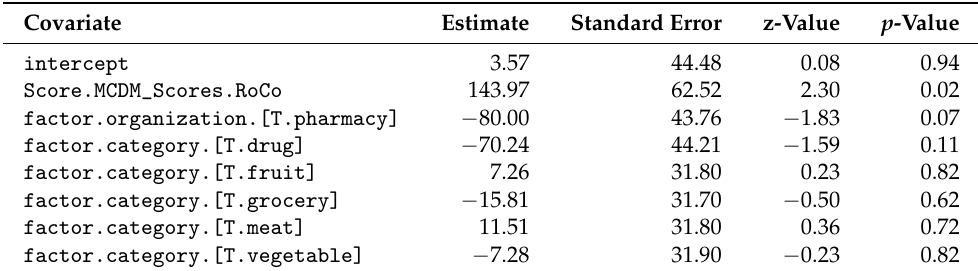
Table 7. Random-effects model considering multilevel and endogeneity: Saving ∼ Score.MCDM_Scores.RoCo + factor.category + factor.organization + ( 1 | organization ) +